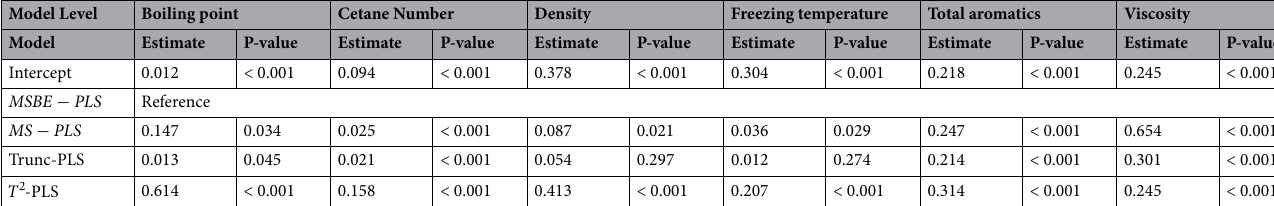
Table 2. The ANOVA results indicating the significant PLS model against each diesel characteristic boiling point at 50% recovery, cetane number, density, freezing temperature of the fuel, total aromatics, and viscosity are presented.